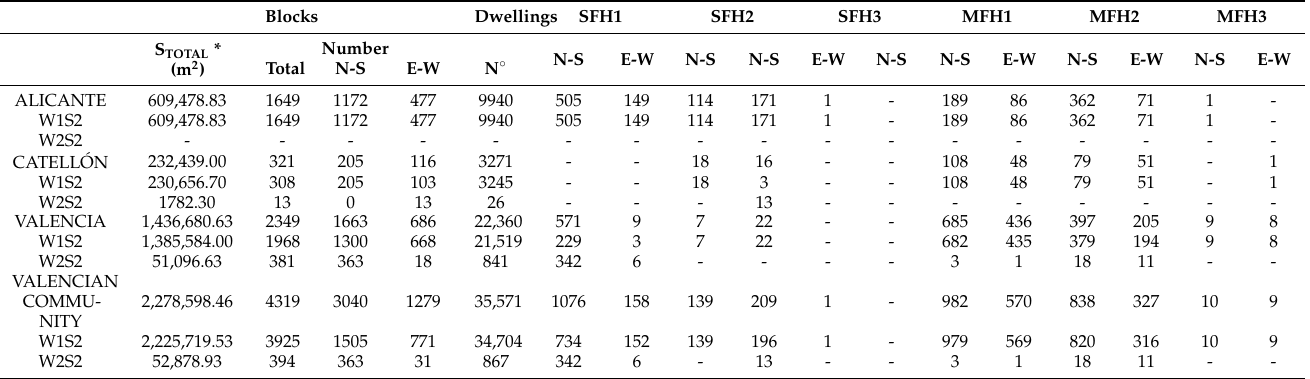
Table 3. EVha’s building stock